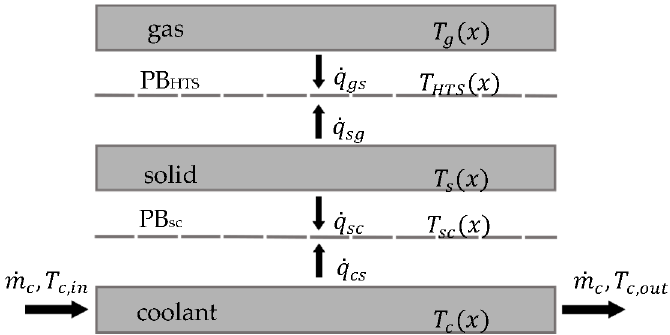
Figure 5. Phase overview of the effective heat transfer model. All temperatures are averaged in the y- and z-directions.